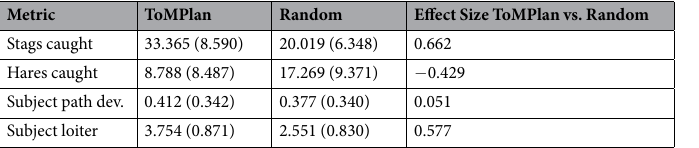
Table 2. Behavioral metrics for subjects by mean and standard